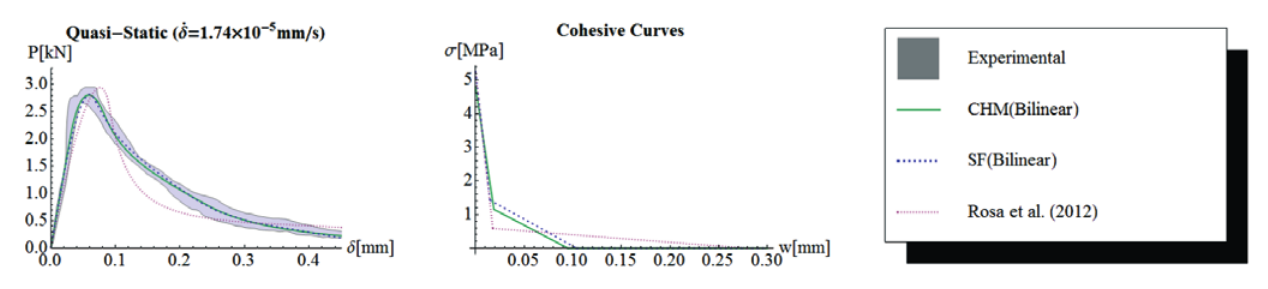
Figure 12 – Comparison of curve obtained by fit of bilinear cohesive modelP-